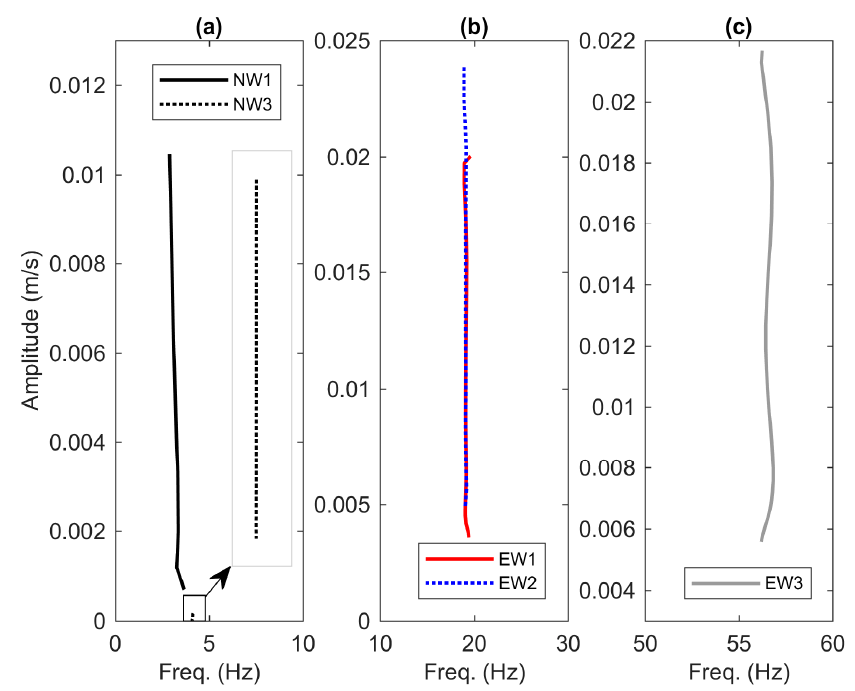
Figure 16b. In addition, the damping curves in Figure 16c will be used as the reference for deriving Figure 15. The backbone curves estimated from the envelope of ( a ) the first mode of numerical analytical models capable of predicting dynamics behaviour of the beam. models, ( b ) the second mode and ( c ) the third mode of the experimental models.